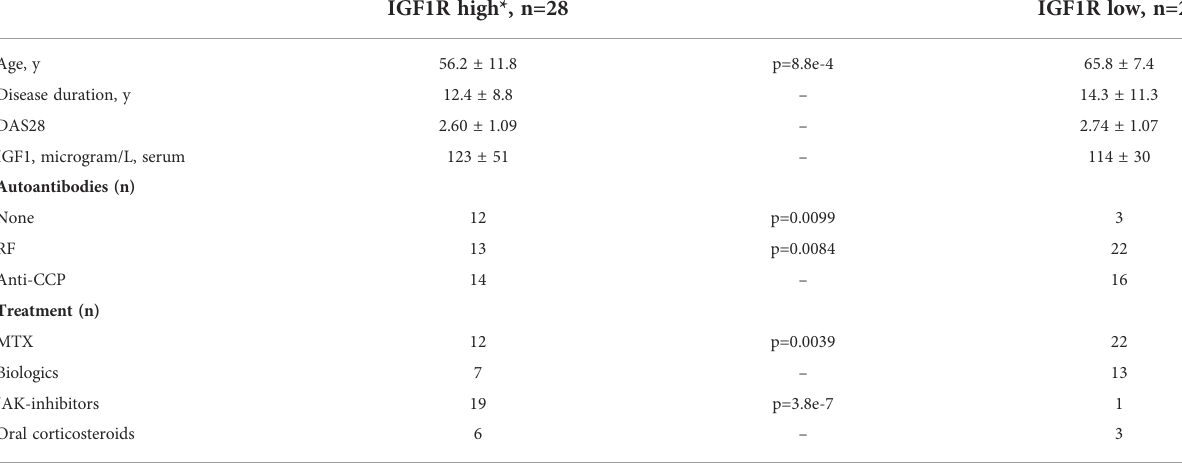
TABLE 1 Clinical characteristics of the patients with rheumatoid arthritis used as a source of CD14 +